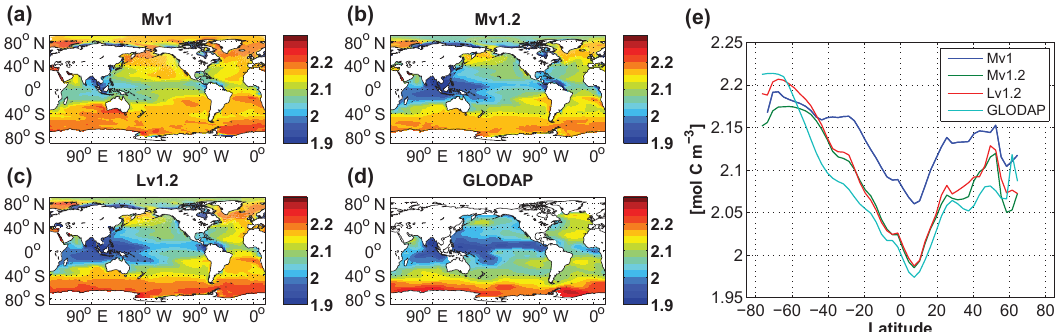
Figure 17. Surface concentration of dissolved inorganic carbon (molm − 3 ) averaged over the years 1988 to 1998 for the model configurations (a) Mv1, (b) Mv1.2, and (c) Lv1.2, and (d) corresponding surface DIC from the observation-based GLODAP climatology. Panel (e) displays the zonal mean of each field presented in panels (a–d) .